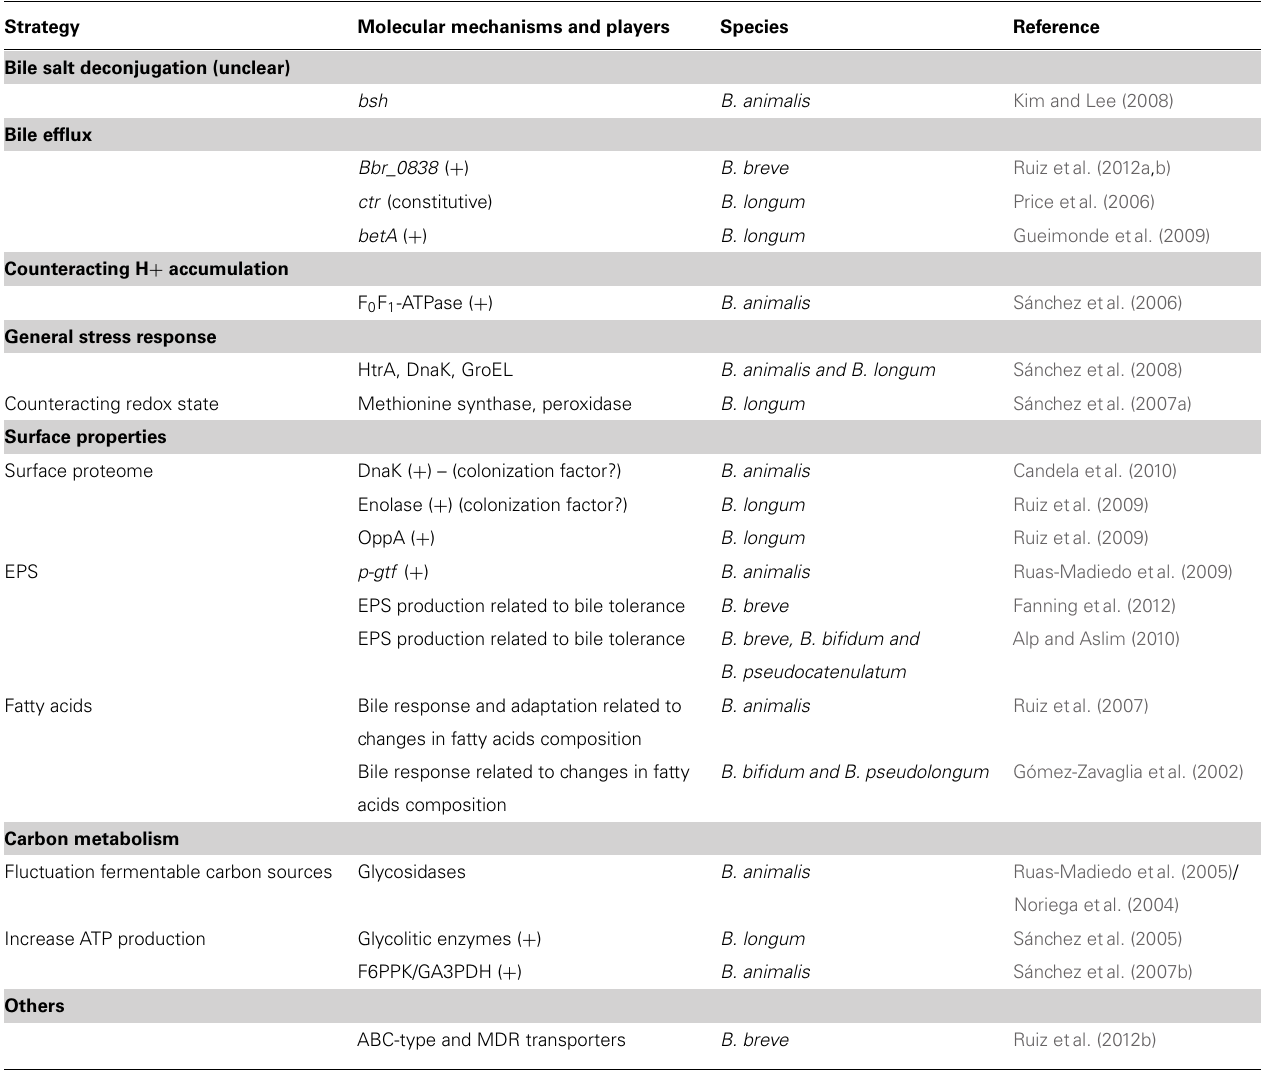
Table 1 | Strategies and molecular elements involved in bifidobacterial bile response and adaptation. Bile induced (+); bile repressed ( −